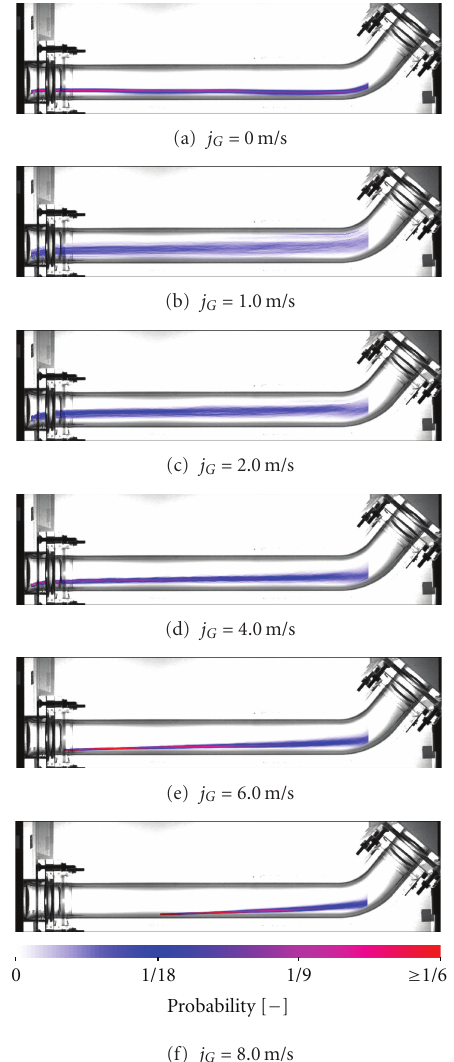
Figure 8: Evolution of the probability distribution of the water level in function of the air flow rate for experiments with j L ,in = 0.25 m/s.